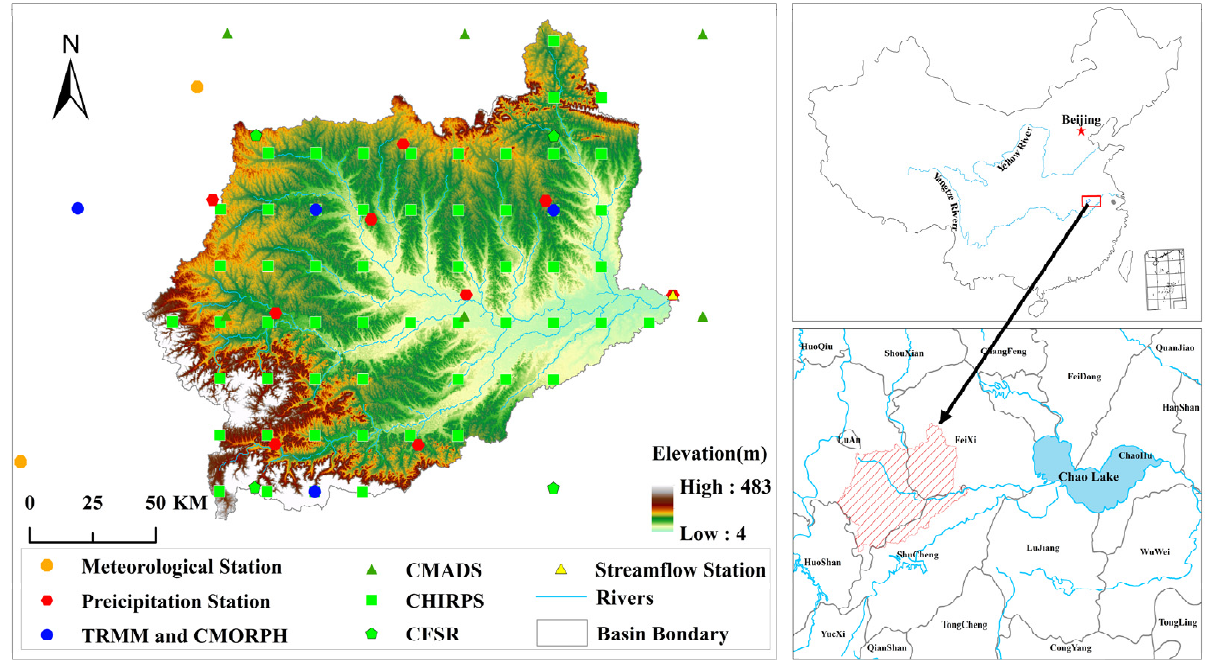
Figure 1. Locations of the Fengle river basin, gauge stations, and the center points of grid cells of the gridded meteorological and precipitation datasets.